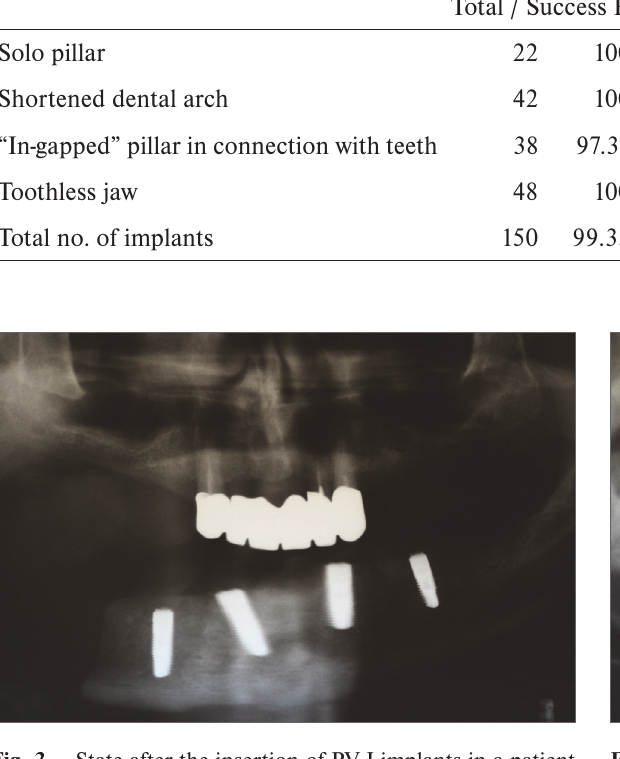
Fig. 3. State after the insertion of PV I implants in a patient after resection of the mandibula.